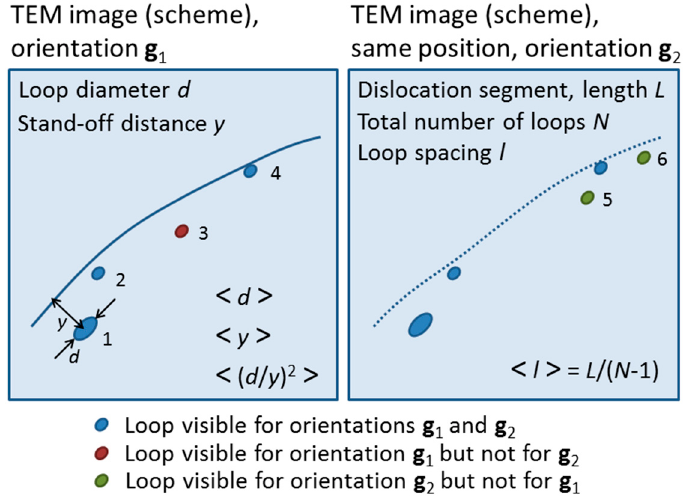
Figure 5. Schematic view of a dislocation segment and loops in a TEM image. < · > denotes arithmetic average.